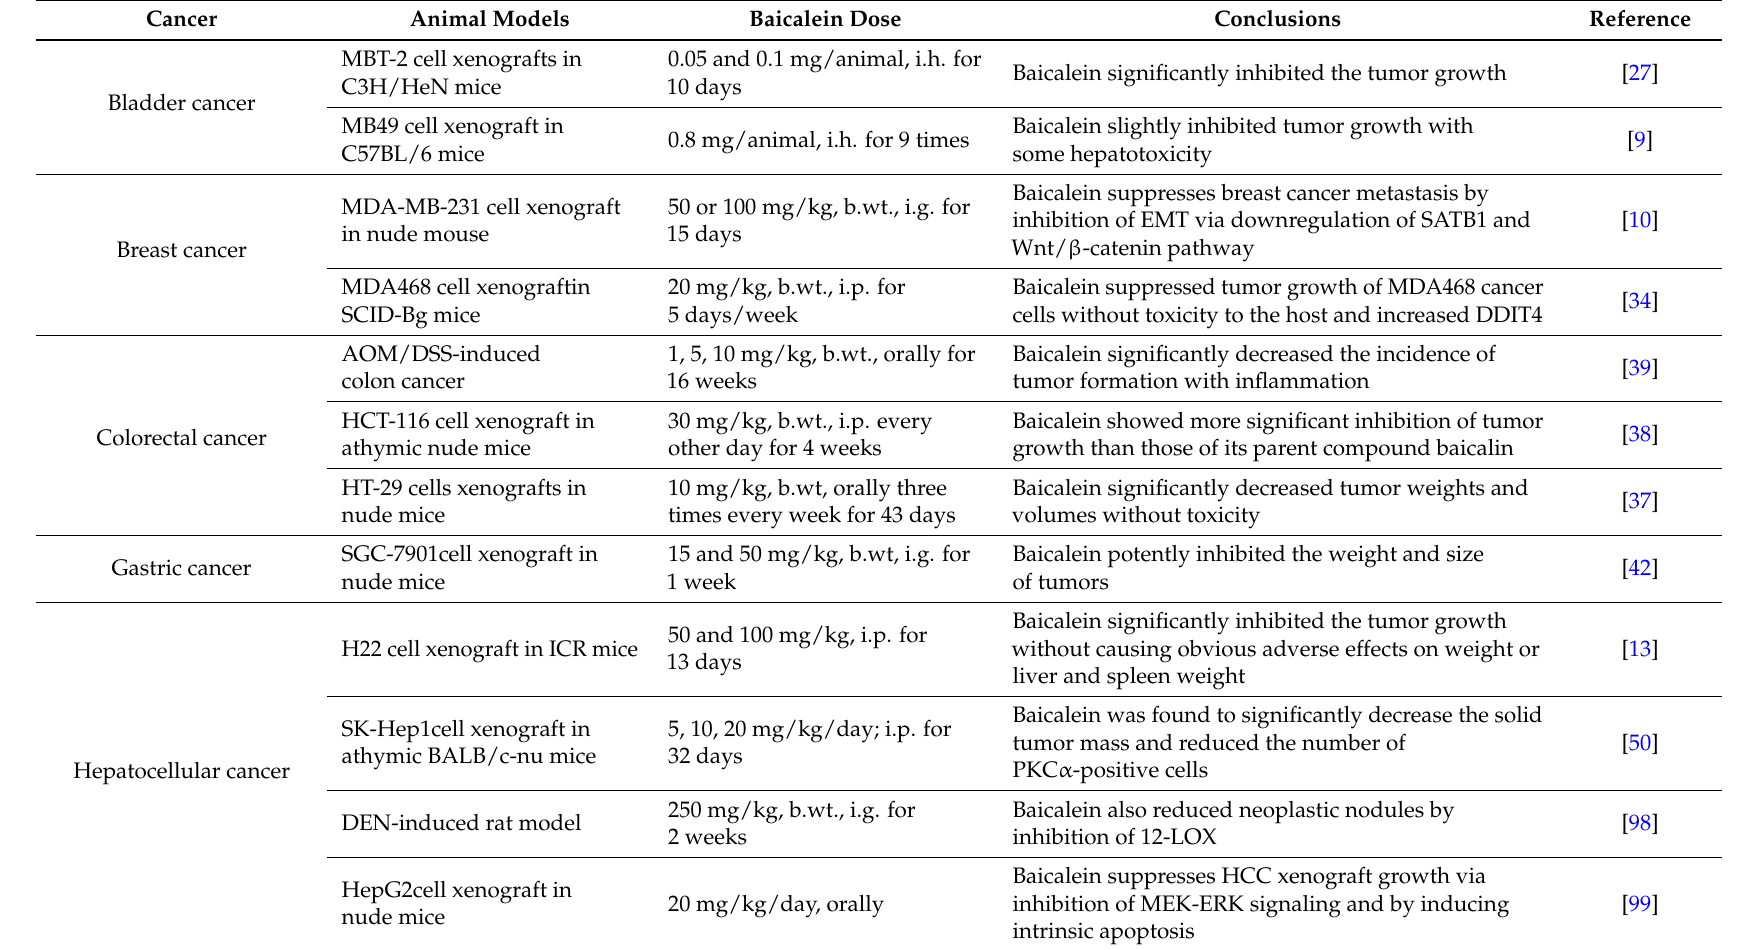
Table 1. Summary of baicalein and its anti-tumor properties in